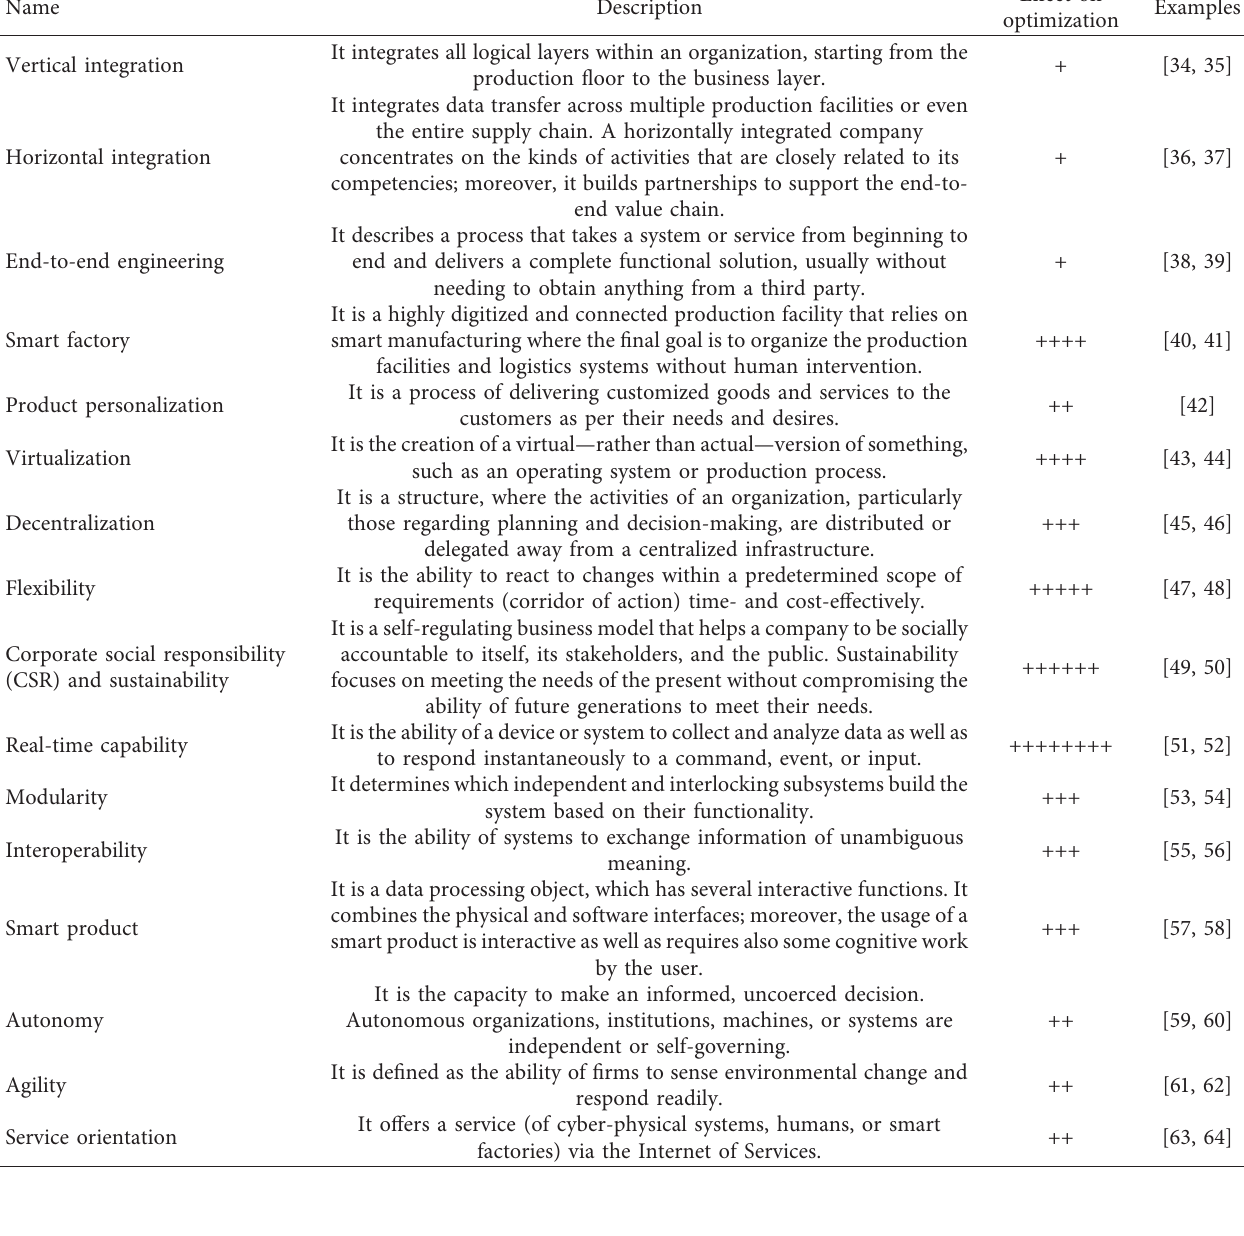
Table 2: Effect of the requirements and characteristics of Industry 4.0 on optimization.